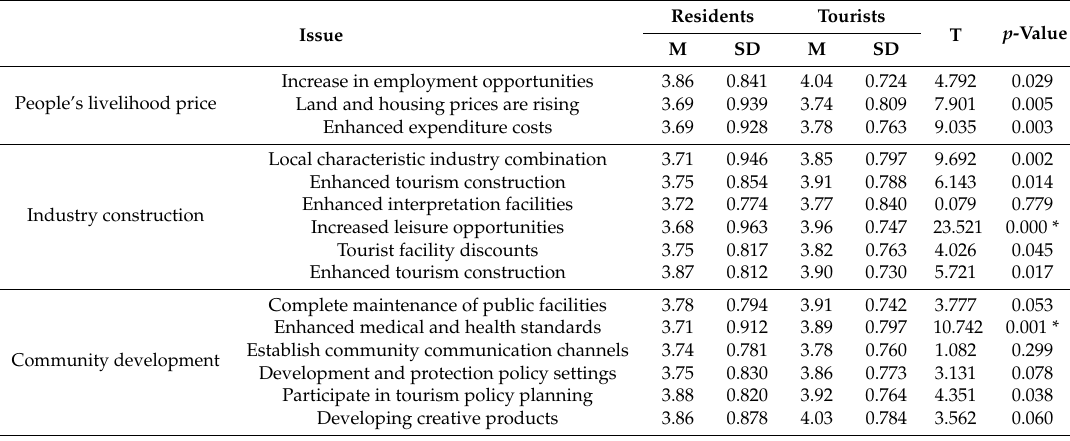
Table 6. An analysis of the di ff erences in the cognition of the current economic development among di ff erent stakeholders.